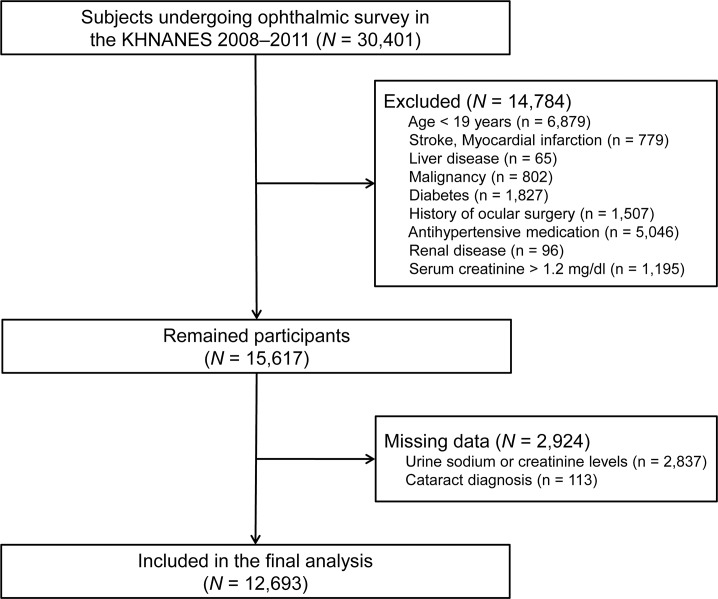
Flow diagram of study participants.